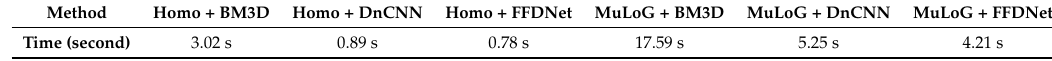
Table 10. The computation time of different